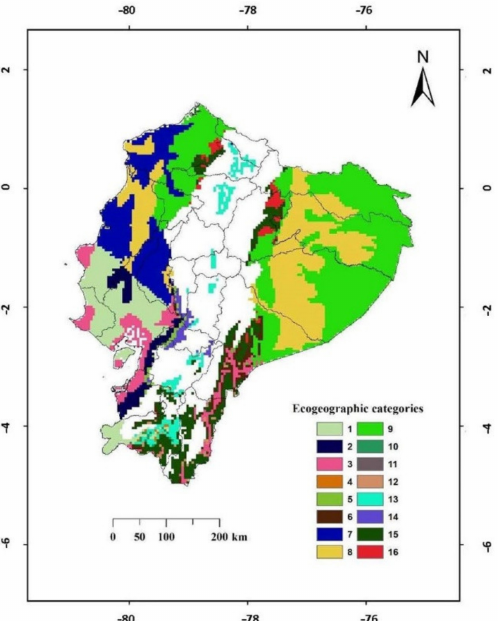
Figure 3. Map of specific ecogeographic characterization in continental Ecuador, where the accessions included in this study were